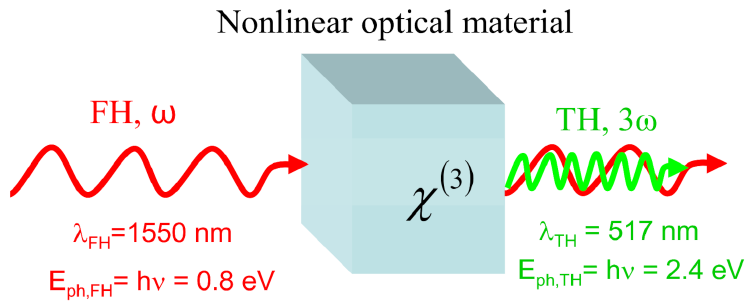
Figure 1. A graphical illustration of the THG